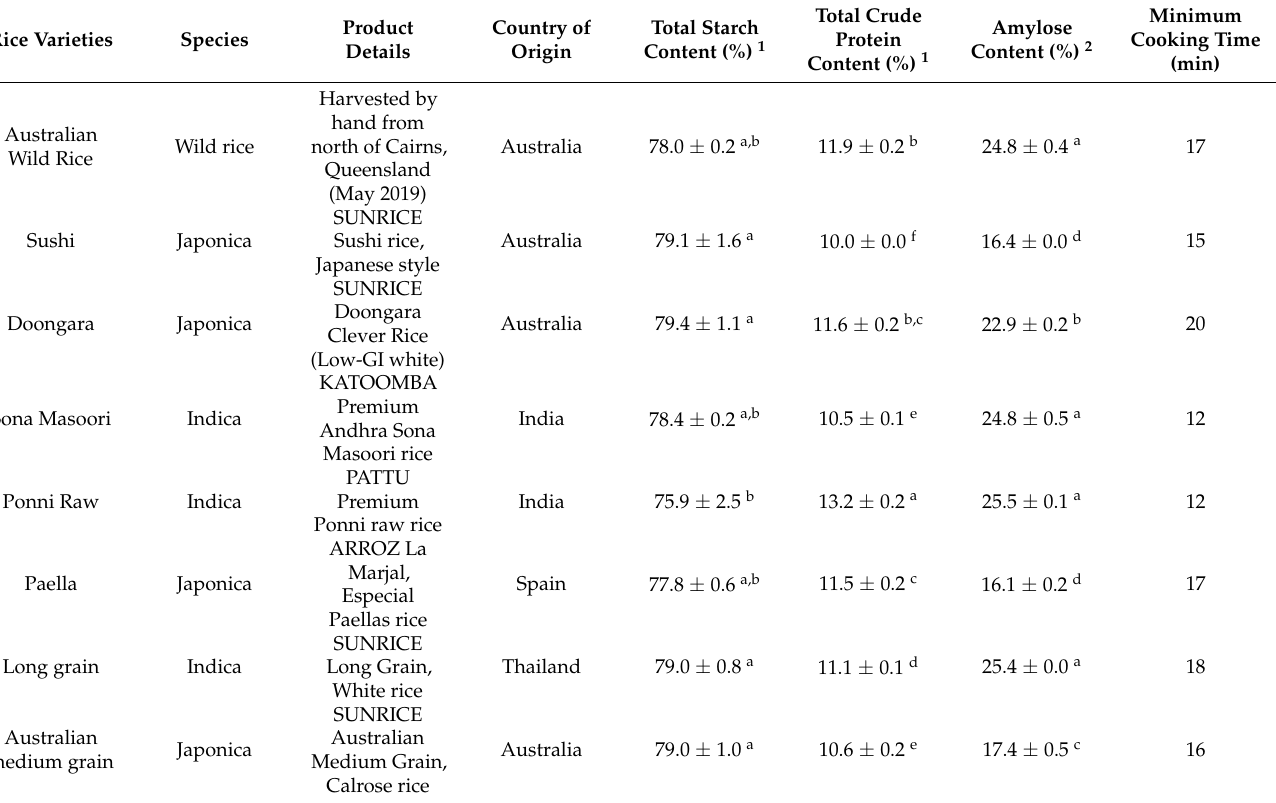
Table 1. Details of the source, chemical compositions, and minimum cooking times of